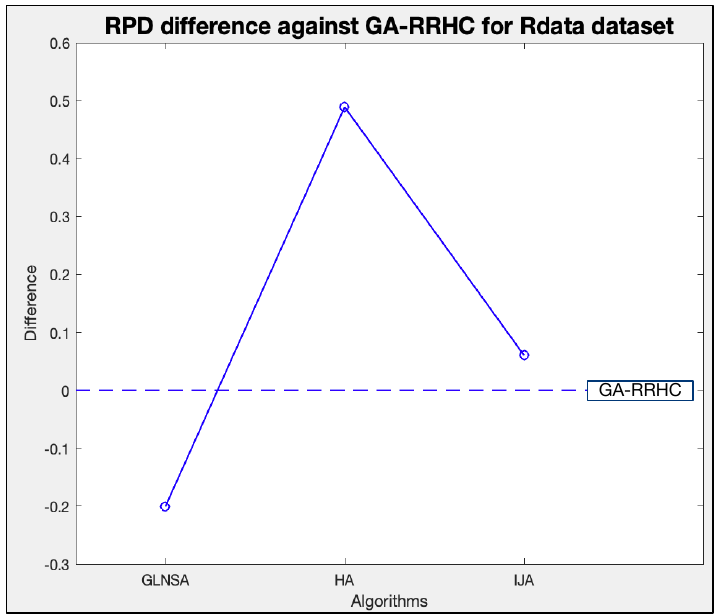
Figure 17. Comparison of the RPD difference per algorithm for the Rdata dataset.